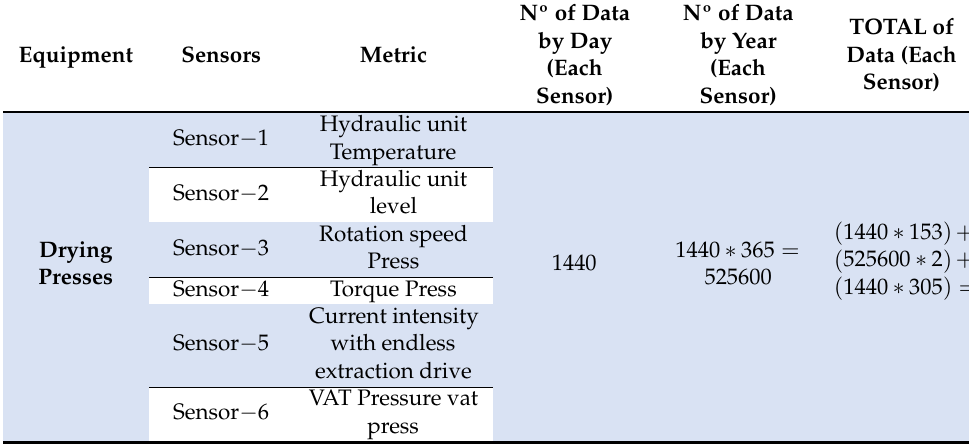
Table 2. Used sensors: Number of data collected.